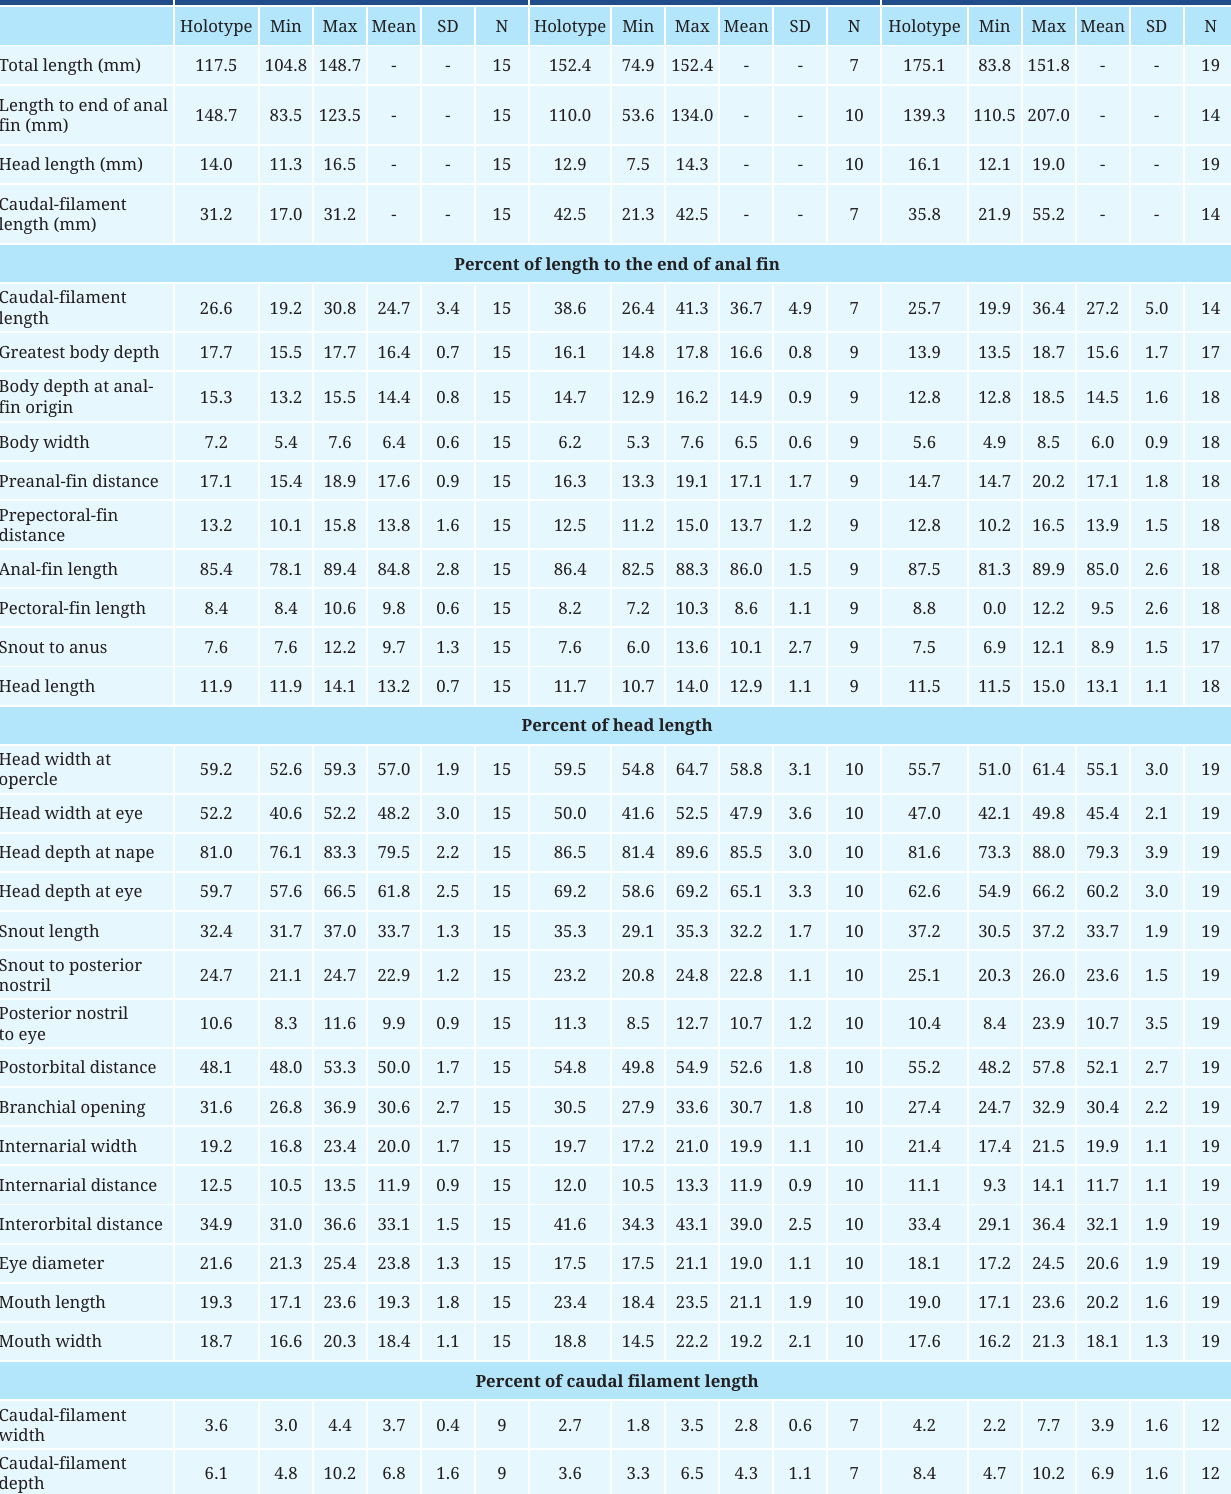
TABLE 1 | Morphometrics for examined specimens of Eigenmannia bumba , E. cacuria , and E. robsoni . Eigenmannia bumba Eigenmannia cacuria Eigenmannia